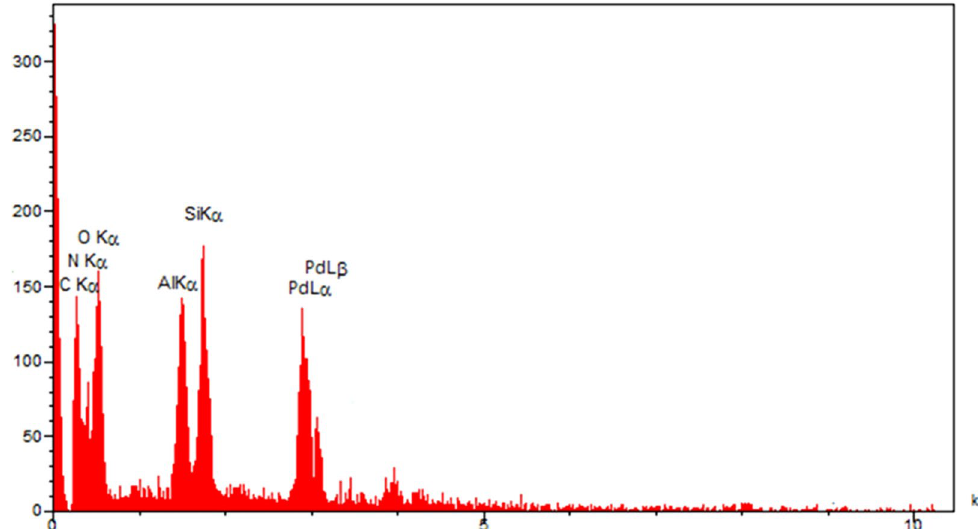
Figure 3. EDX spectrum of Pd@Hal-DAB-PC.